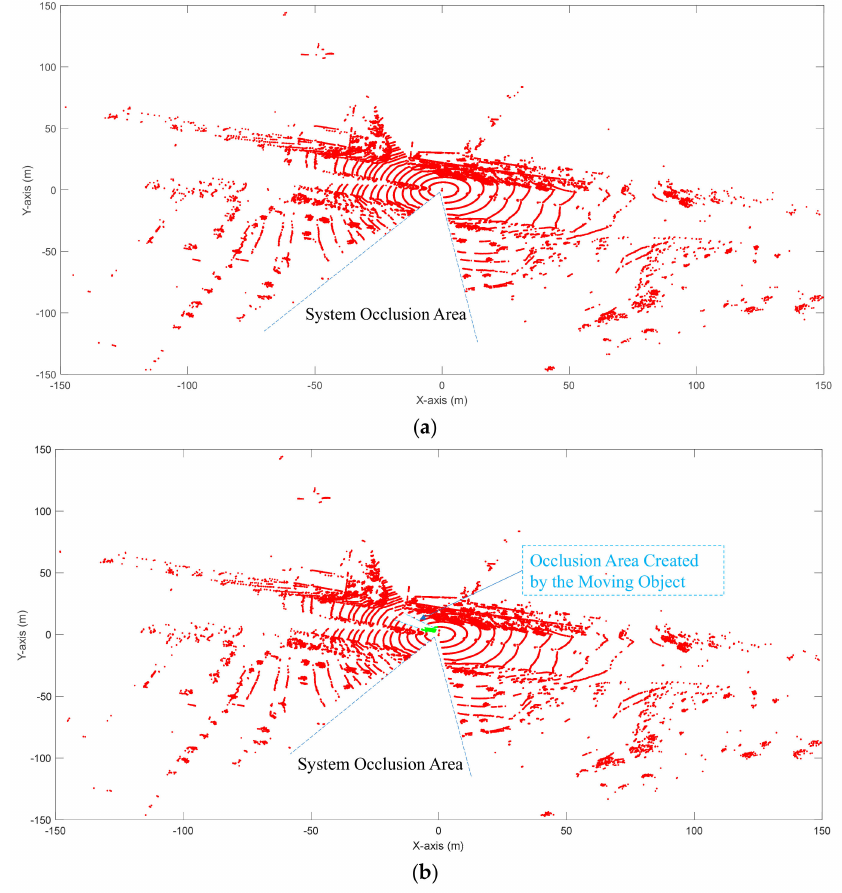
Figure 4. Occlusion issue: ( a ) Non-occlusion area created by moving objects, ( b ) Occlusion area created by moving